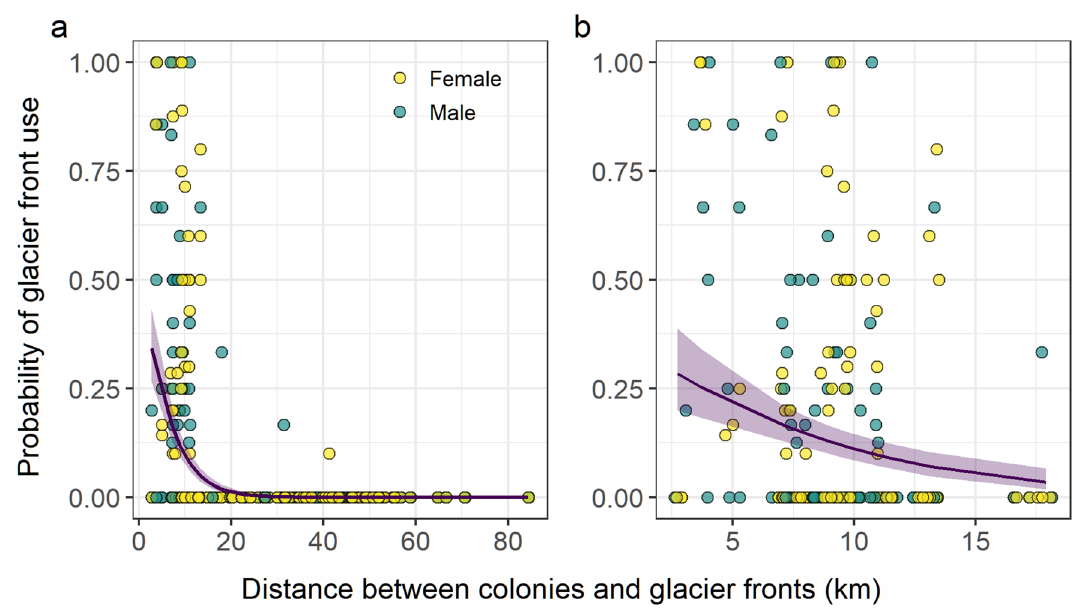
Figure 3. Relationship between black-legged kittiwake use of glacier fronts as a function of the distance separating their colonies to a given front at two different scales; ( a ) regional scale; involving 5 colonies and 25 glacier fronts (effect of distance; estimate = − 0.22, 95% CI = − 0.26: − 0.18) and ( b ) fjord scale; involving 4 colonies and 6 glacier fronts (effect of distance; estimate = − 0.16, 95% CI = − 0.22: − 0.09). For the ease of representation, points represent individual males and females average use (circles: yellow = female; green = male) of glacier fronts. Solid curves and shaded areas are the regression line and associated 95% confidence interval (back-transformed) estimated from generalized linear mixed models, using the glacier front use as response variable, the distance, sex and colony as additive fixed predictors and the bird ID as random